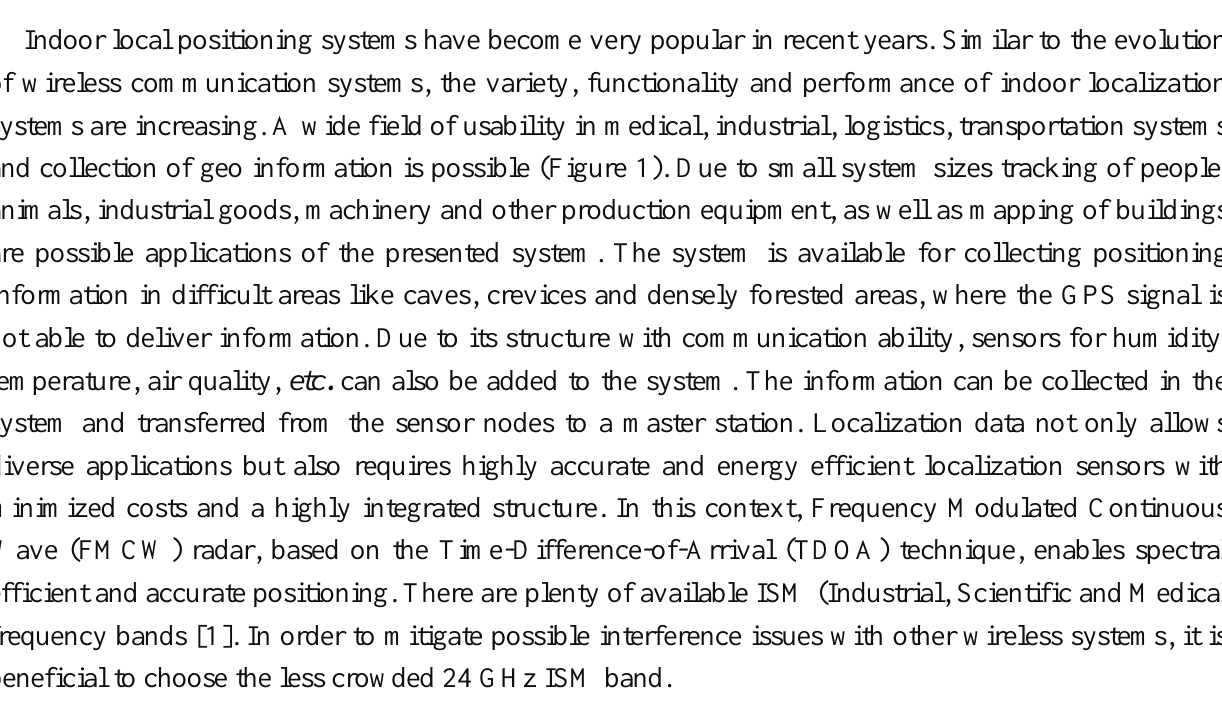
Figure 1. Illustration of the possible application of the sensor